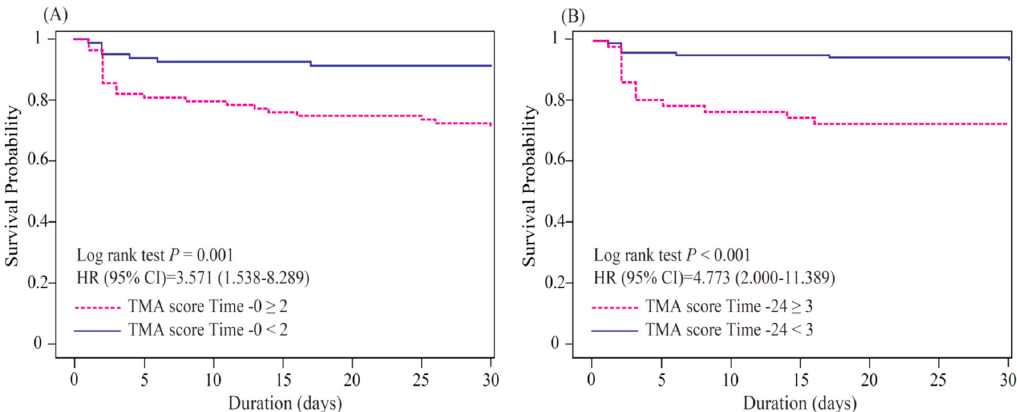
Figure 3. The thrombotic microangiopathy (TMA) score as a predictor of 30-day mortality. Higher TMA scores at admission ( A ) and 24 hours ( B ) after admission were significantly associated with an increased risk of 30-day mortality among patients with septic shock.